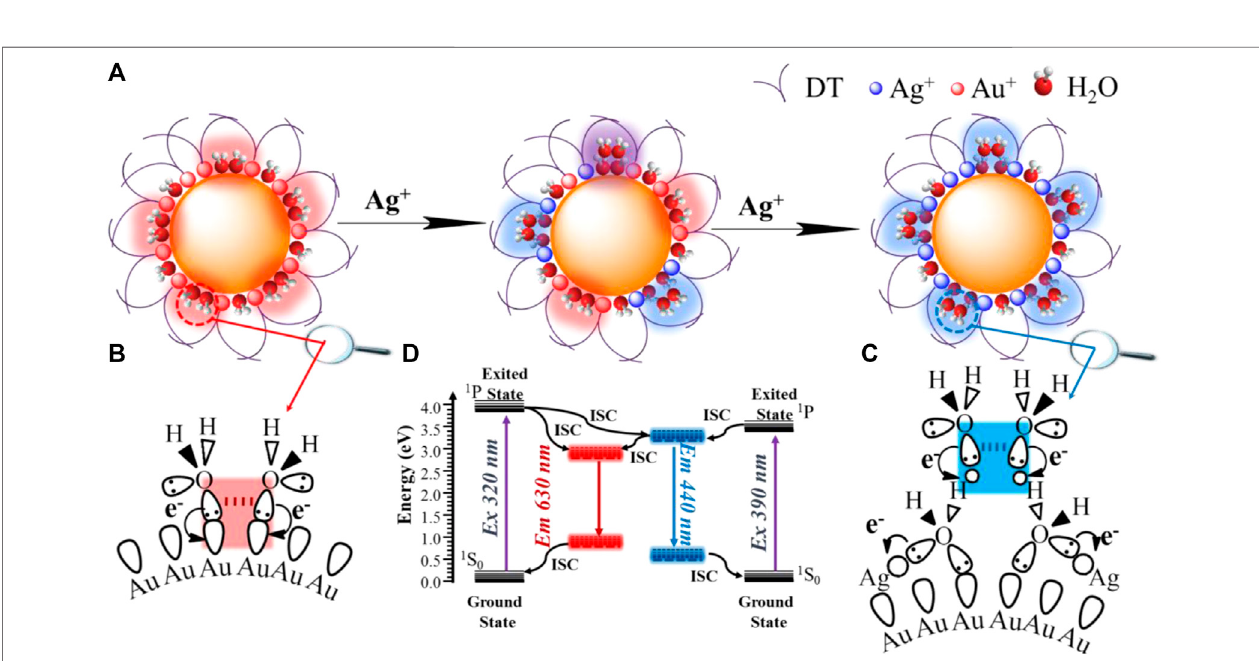
FIGURE 5 | Schematic illustration of structural water molecules (SWs) con fi ned at nanoscale interface of Au – Ag bimetal NCs packed by protective ligands emit bright dual-photoluminescence (A) , the red emissive SWs strongly binding on the single metal Au NCs (B) , the blue emissive SWs weakly binding on the fully core-shell structured Au-Ag bimetal Au NCs though water bridge which strongly coordinated with Ag + (C) , and energy diagram of dual emissions of Au-Ag bimetal NCs (D) .